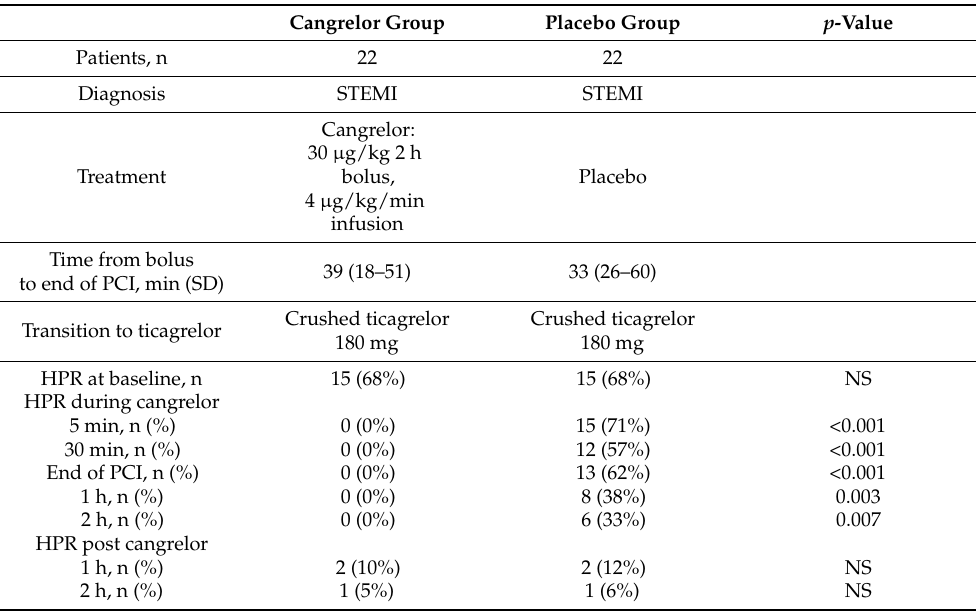
Table 2. Characteristics of patients randomized in the CANTIC trial